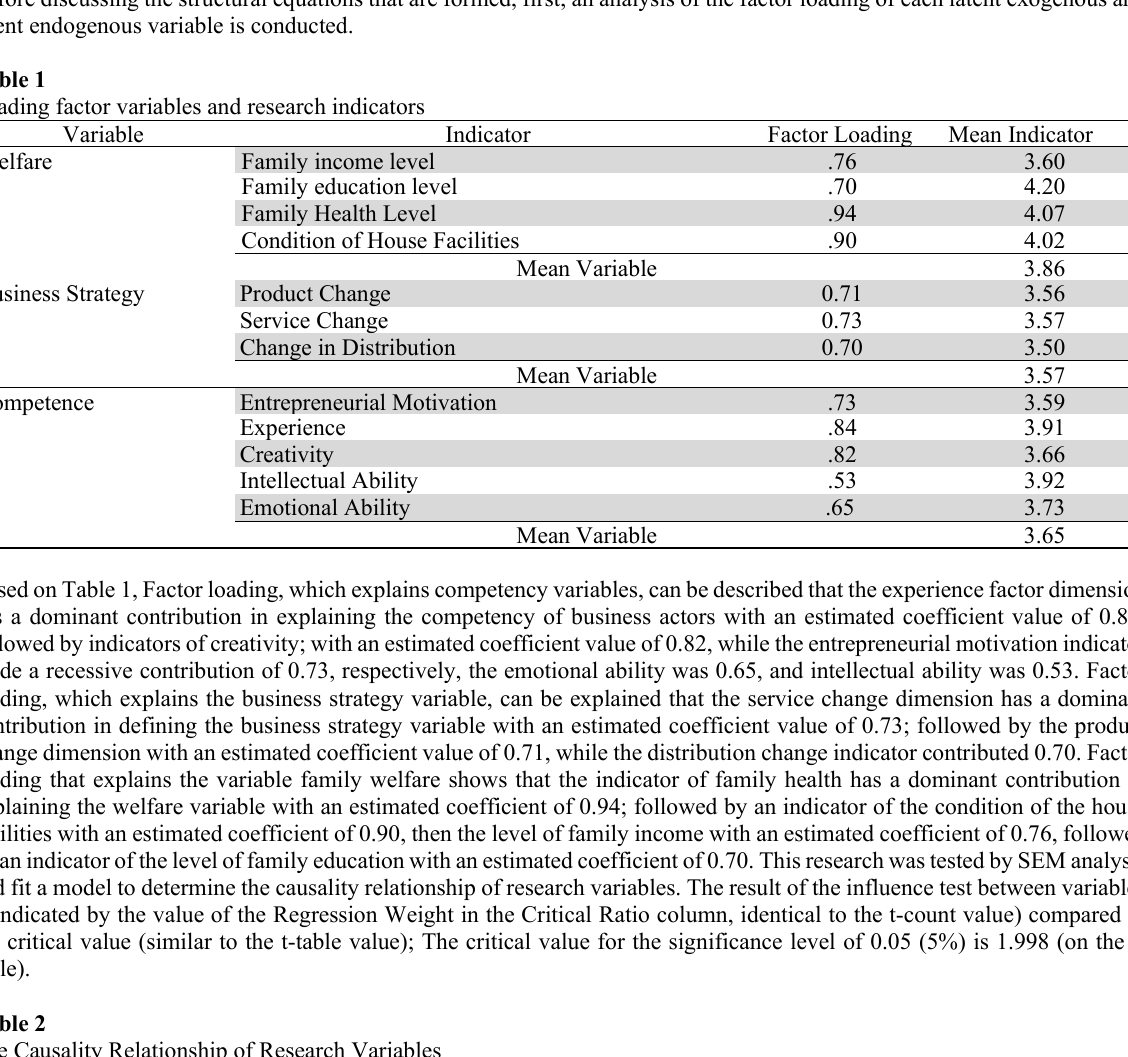
The Causality Relationship of Research Variables Variable